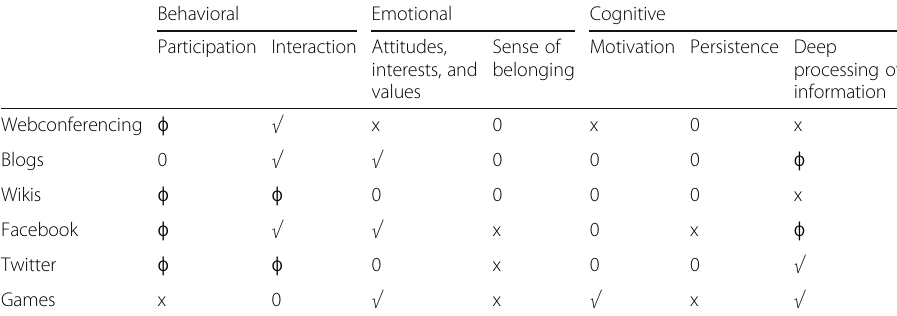
Table 1 Summary of Findings by Technology and Engagement Indicator Behavioral Emotional Cognitive Participation Interaction Attitudes, Sense of Motivation Persistence Deep interests, and belonging processing of values